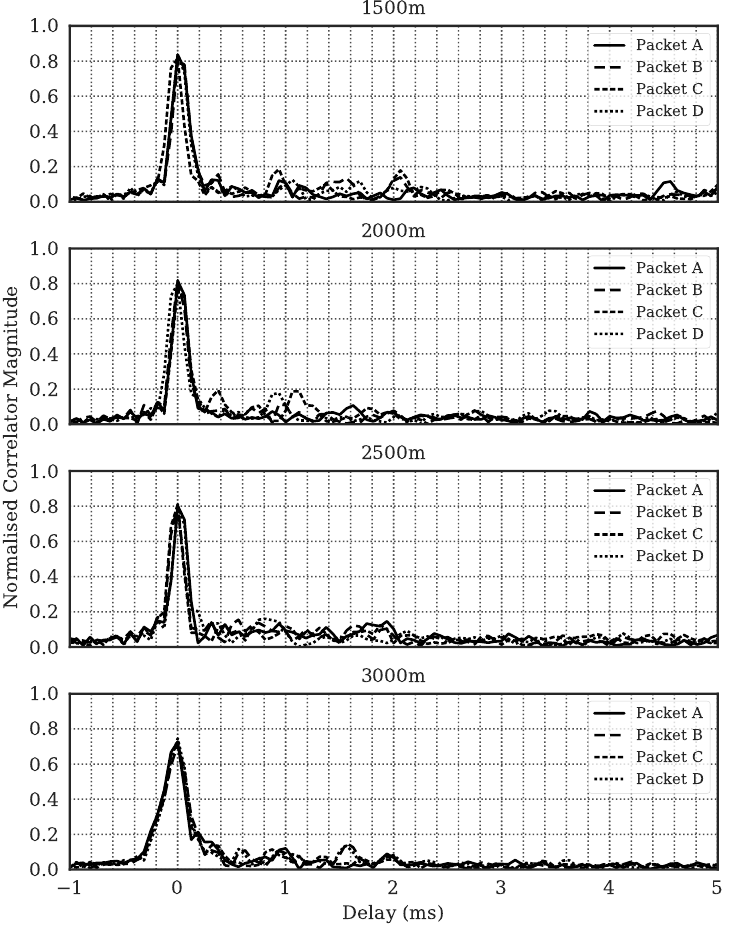
Figure 13. Loch Ness channel impulse responses for range